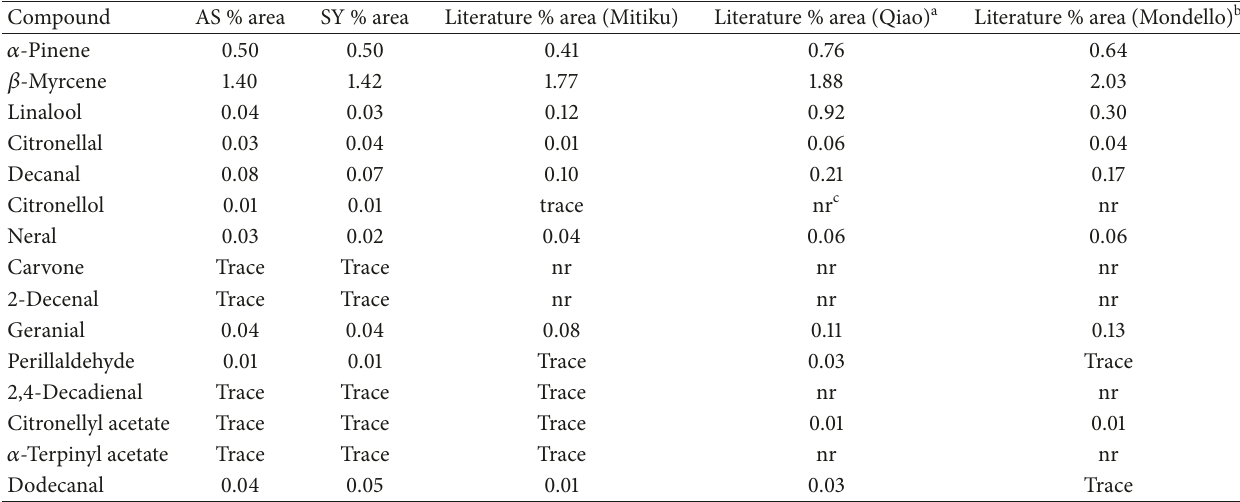
Table 11: Hamlin peak area comparison to the literature